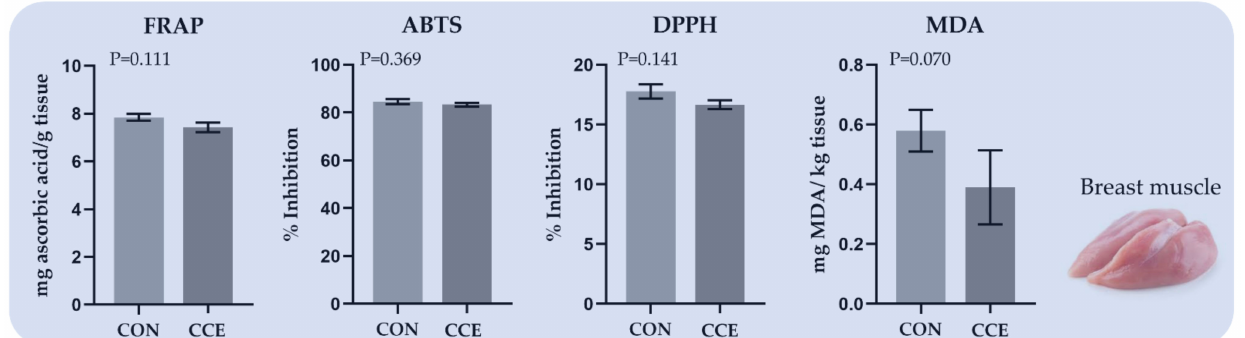
Figure 2. The total antioxidant capacity and lipid peroxidation index of breast muscle of broilers fed the two diets (Control; CON and carotenoid extract from Citrus reticulata included in soluble starch; CCE) at 42 days. FRAP: Ferric Reducing Ability of Plasma, ABTS: 2,2 (cid:48) -azinobis-(3-ethylbenzothiazoline-6- sulfonate), DPPH: 2,2 (cid:48) -diphenyl-1-picrylhydrazyl radical, and MDA: Malondialdehyde